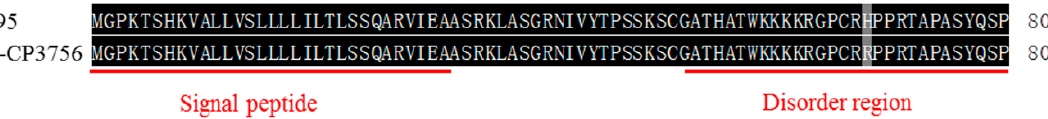
Figure 5. Amino acid sequence alignment of BnaA02T0157000ZS in NJAU-M1295, NJAU-CP3756, and ZS11.